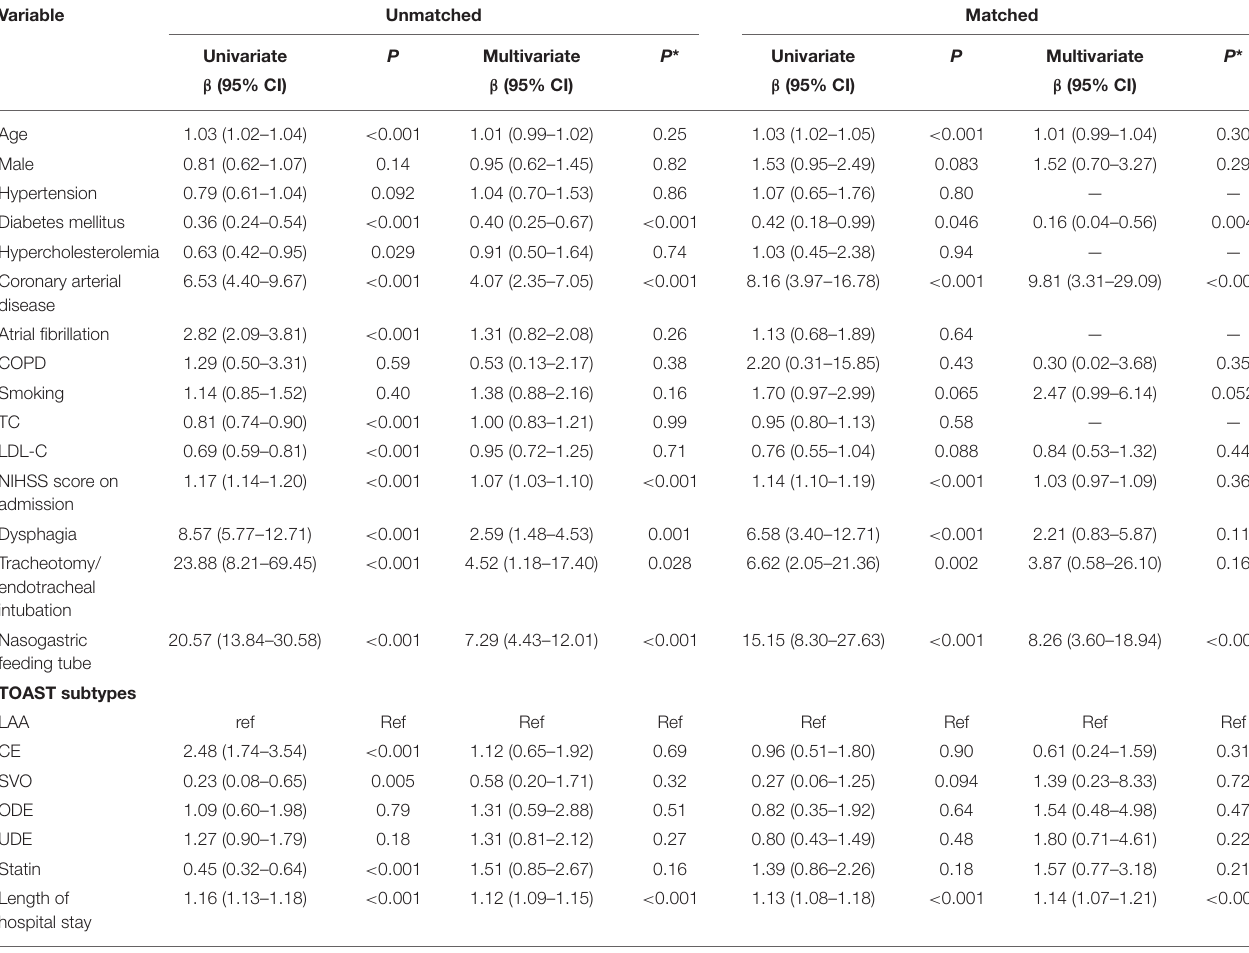
TABLE 3 | Univariate and multivariate analysis for the risk of post-stroke pneumonia before and after propensity score matching. Variable Unmatched Matched Univariate P Multivariate P * Univariate P